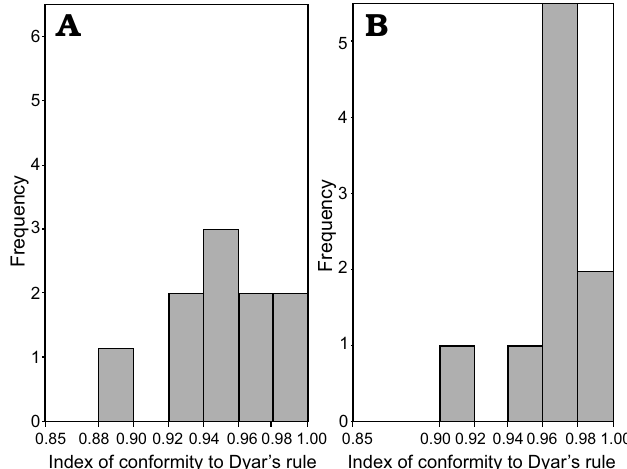
Fig. 13. Frequency distribution of the index of conformity to Dyar’s rule from the D4 to D16 of Changaspis elongata Lee in Chien, 1961. A . Cephalic length (n = 13). B . Trunk length (n =